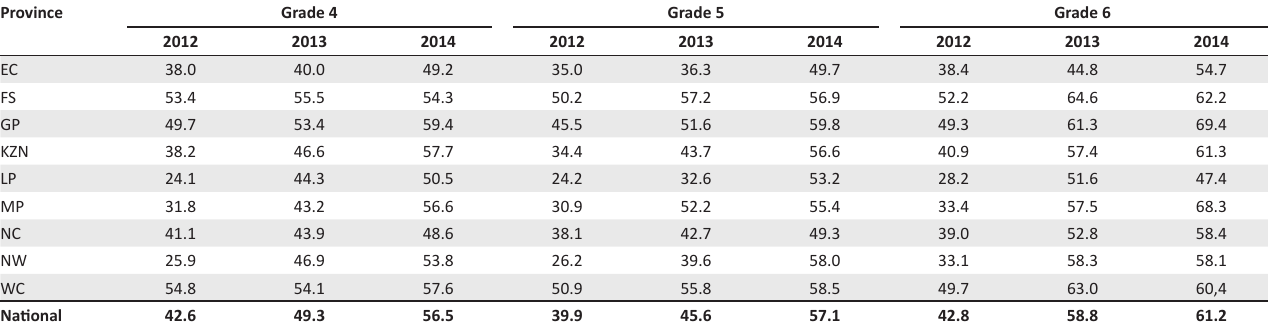
TABLE 2: Overall average results for Annual National Assessment (English home language) in the Intermediate Phase.